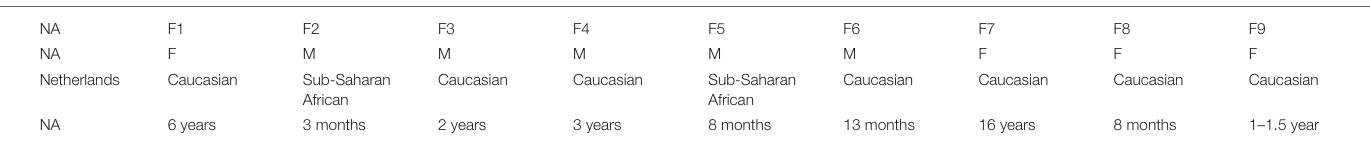
Initial serum Mg 2 + (mmol/L)